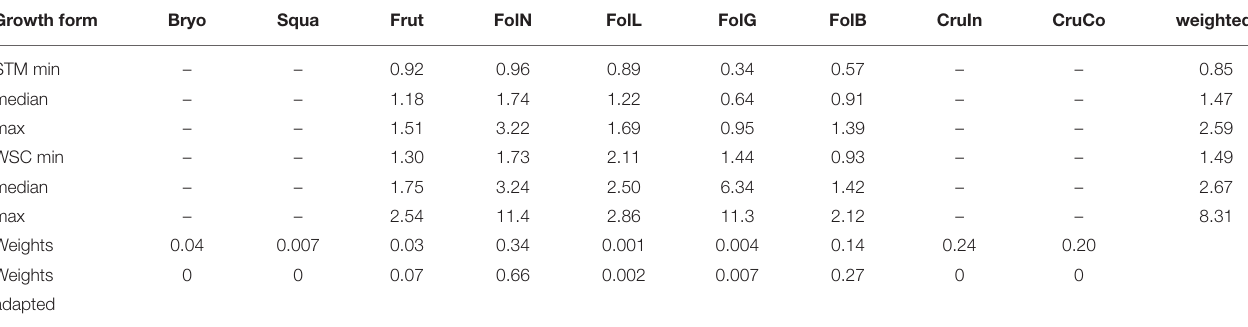
TABLE 1 | Minimum, median, and maximum values of specific thallus mass (STM, [kgm − 2 ]) and water storage capacity (WSC, [kgm − 2 ]) for different growth forms of NV epiphytes which are found in the study